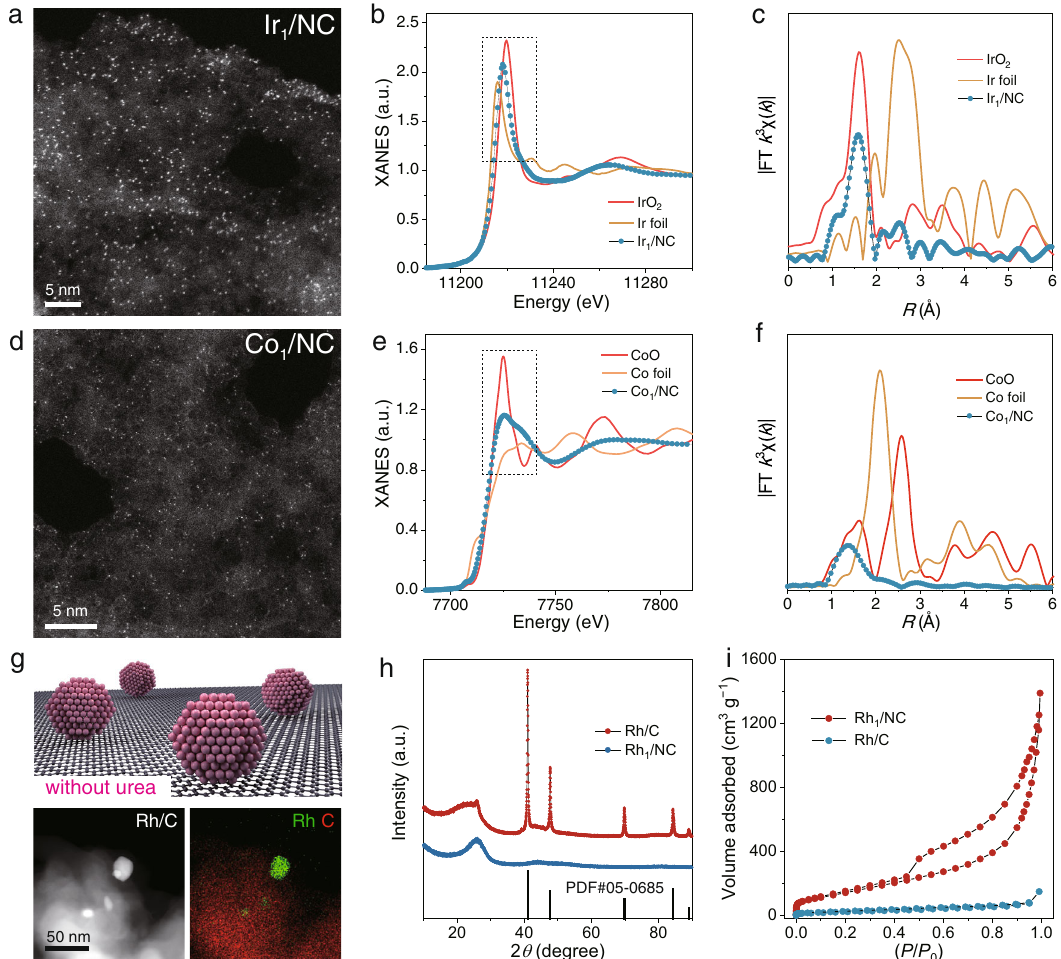
Fig. 2 Characterization of Ir 1 /NC, Co 1 /NC and Rh/C. a Atomic-resolution HAADF-STEM images of Ir 1 /NC. b Ir L-edge XANES spectra of Ir 1 /NC, Ir foil, and IrO 2 . c FT-EXAFS spectra at the Ir L-edges of Ir 1 /NC, Ir foil, and IrO 2 . d Atomic-resolution HAADF-STEM image of Co 1 /NC. e Co K-edge XANES spectra of Co 1 /NC, Co foil, and CoO. f FT-EXAFS spectra at the Co K-edges of Co 1 /NC, Co foil, and CoO. g Schematic illustration of Rh/C synthesized without urea and the HAADF-STEM image with energy-dispersive X-ray elemental mapping of Rh/C. h XRD patterns of Rh 1 /NC and Rh/C. i N 2 adsorption- desorption isotherms of Rh 1 /NC and Rh/C. Experiment (Fig. 2a, d, g) was repeated 3 times independently with similar